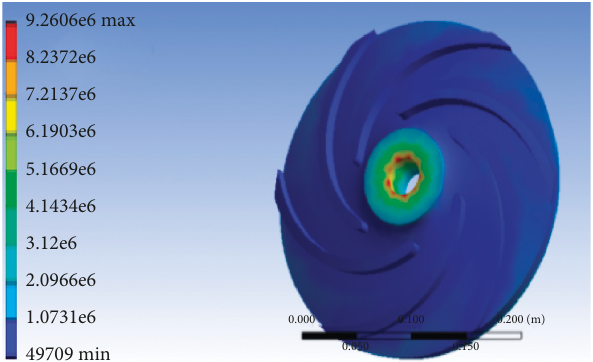
Figure 17: Total displacement and deformation before optimization.